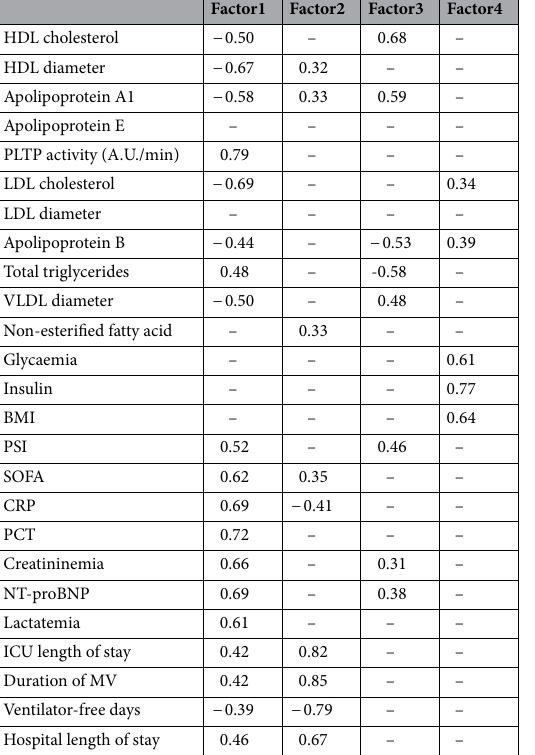
Table 2. Principal component analysis of clinical and lipid characteristics. Data are expressed as correlation coefficients. Values less than 0.3 are not edited. HDL high density lipoprotein, PLTP phospholipid transfer protein, LDL low density lipoprotein, VLDL very low density lipoprotein, BMI body mass index, PSI pneumonia severity index, SOFA sequential organ failure assessment, CRP C reactive protein, PCT procalcitonin, BNP brain natriuretic peptide, ICU intensive care unit, MV mechanical